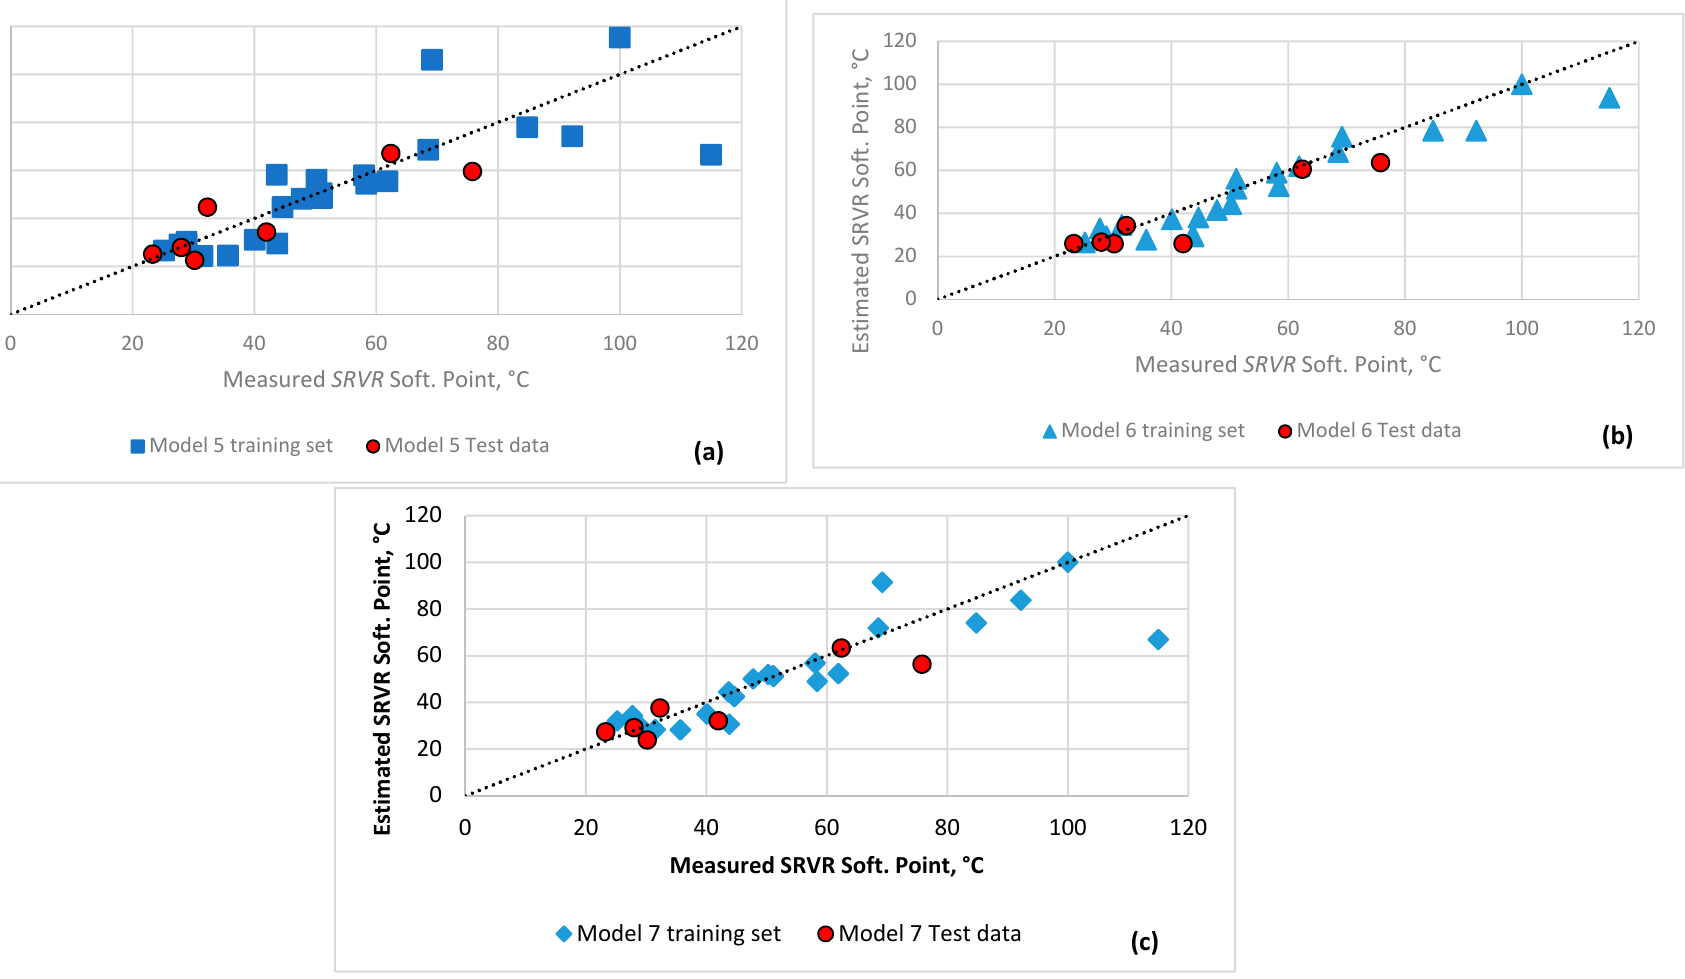
Figure 3. Agreement between measured data and that predicted by Models 5–7 for the softening point of SRVRs: ( a ) Model 5; ( b ) Model 6; ( c ) Model 7.